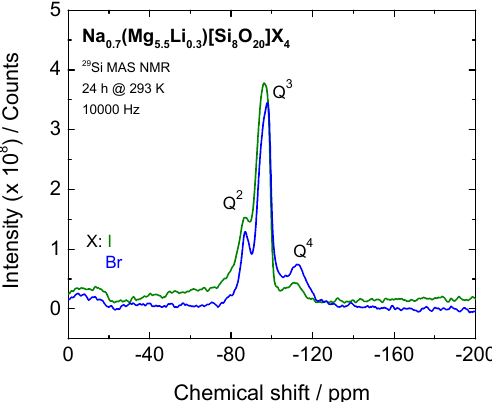
Figure 4. The 29 Si MAS NMR spectra of bromohectorite and iodohectorite clay